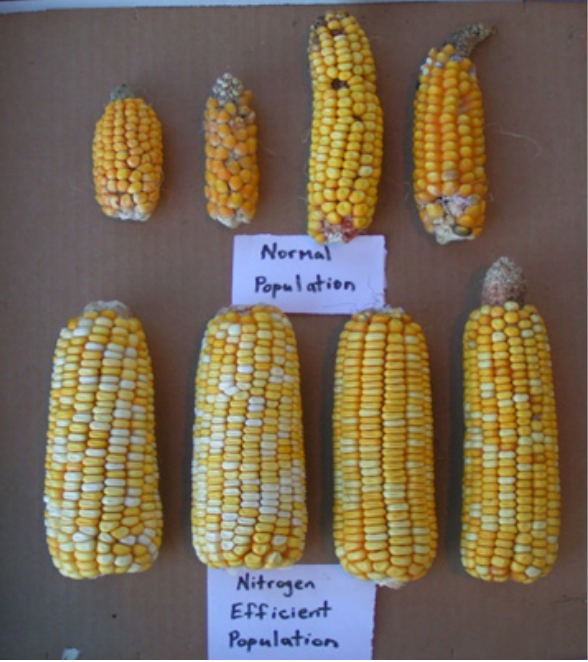
Figure 7: Differences in ear size for check population CG-SS at top and for population ‘C’at bottom when grown on a low organic matter, loamy sand soil in 2013 near Eagle,